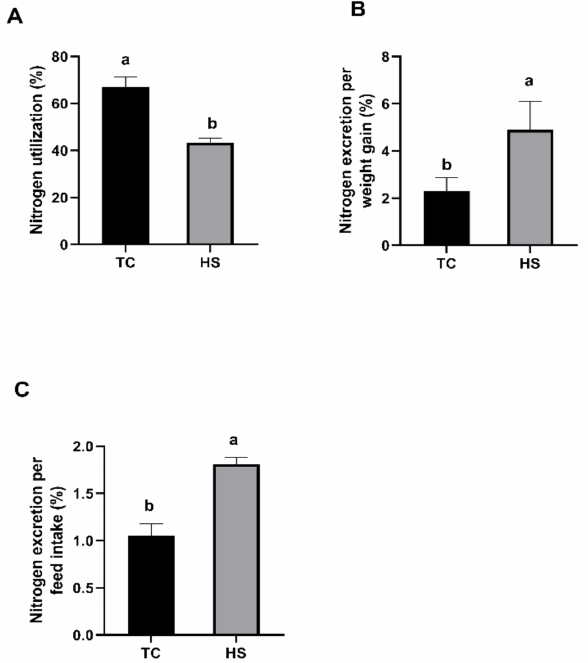
Figure 1. Effects of heat stress on the nitrogen utilization ( A ), nitrogen excretion per weight gain ( B ) and nitrogen excretion per feed intake ( C ) of broilers. TC, thermoneutral control group; HS, heat stress group. Each bar presents the means ± SD ( n = 6). a,b Values with different superscripts differ significantly at p < 0.05.